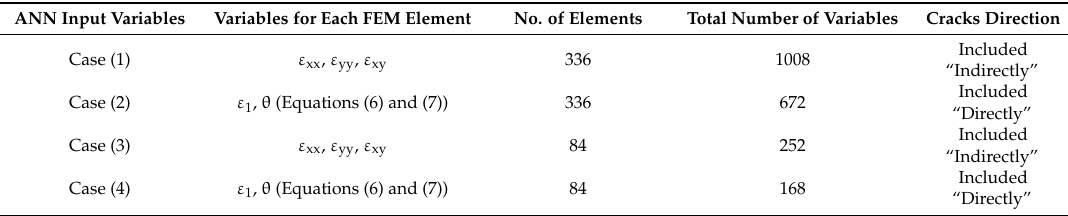
Table 2. Four sets of input variables for choosing the best performance artificial neural networks (ANN)